Question: What type of chart is this?
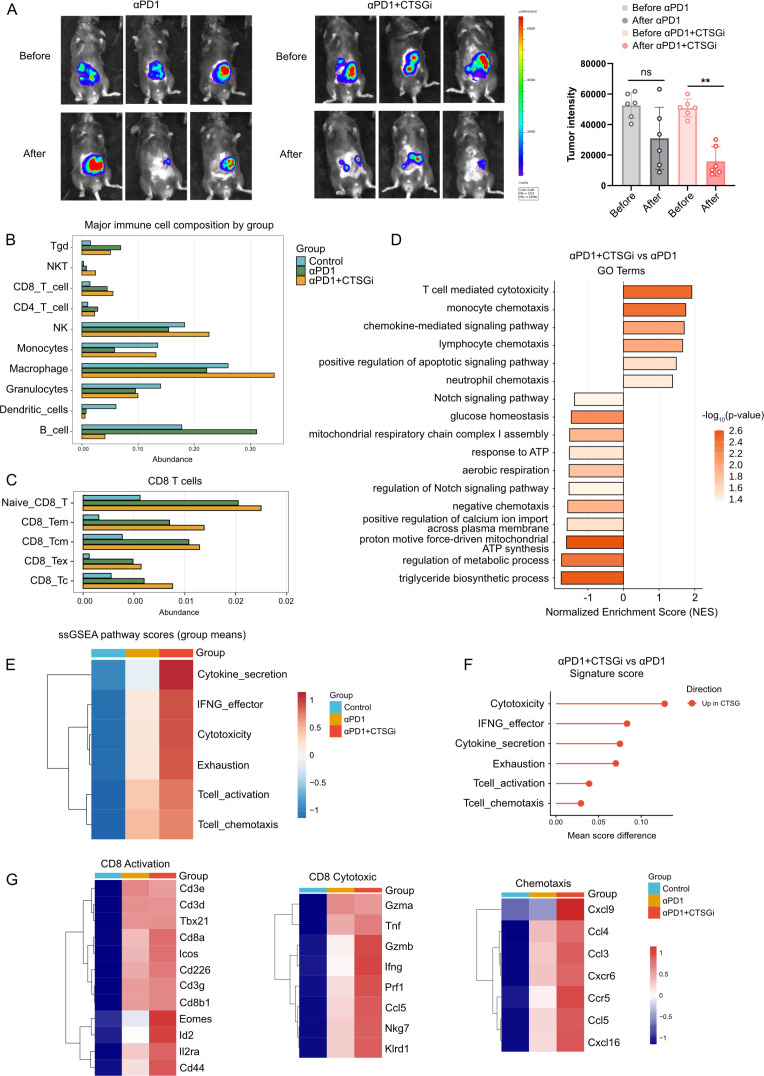
Answer: heatmap